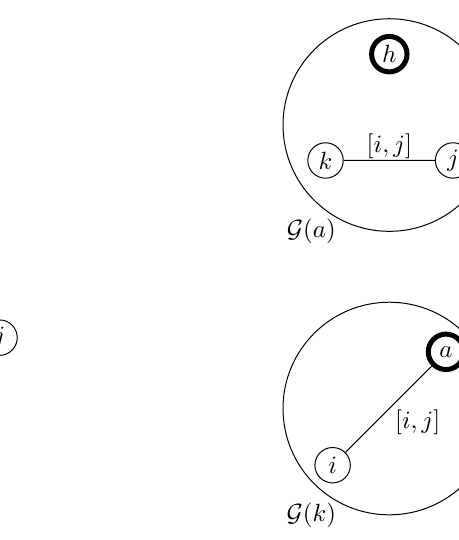
Figure 5 An example of links added to local subgraphs when a candidate alternative edge is considered. In each local subgraph, the vertex corresponding to the predecessor is drawn in thick line.